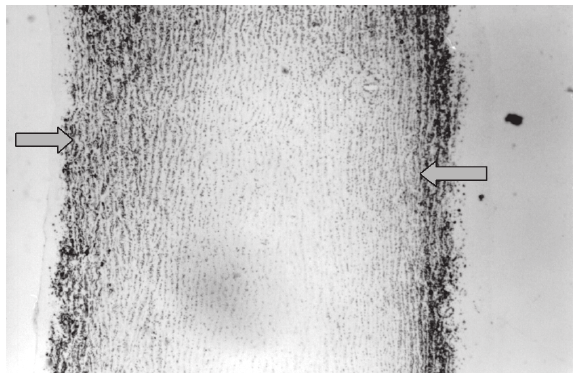
Fig. 9 - Fotomicrografia mostrando corte longitudinal da parede aórtica tratada com ácido L-glutâmico, apresentando calcificação difusa e acentuada, após 60 dias do implante. AG subgrupo 60 dias (von Kossa